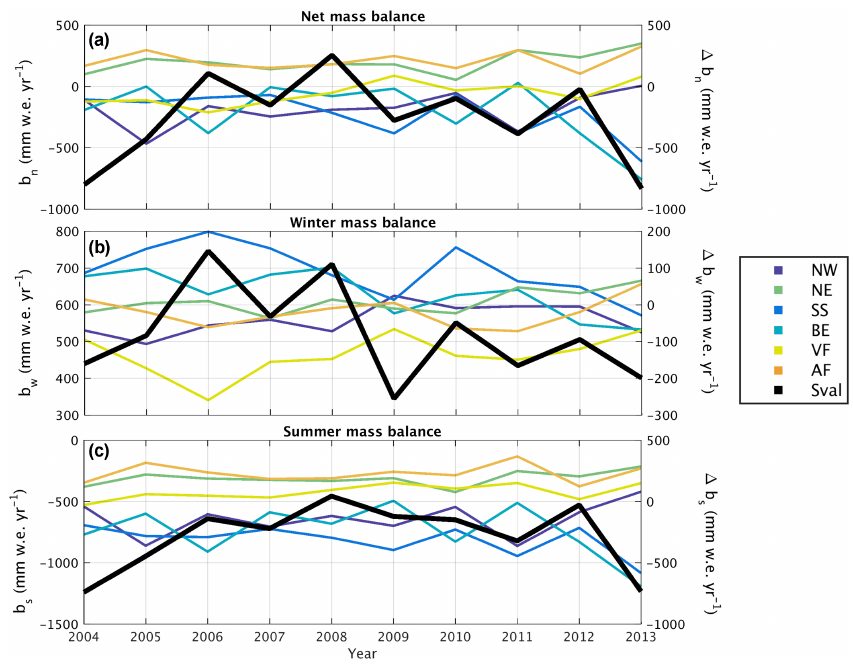
Figure 9. (a) annual mean mass balance (mw.e.yr − 1 ) for Svalbard (black, left y axis) and regional deviations (colors, right y axis). (b) Same as (a) but for winter-mass balance (September to April). (c) Same as for (a) but for summer mass balance (May to August).